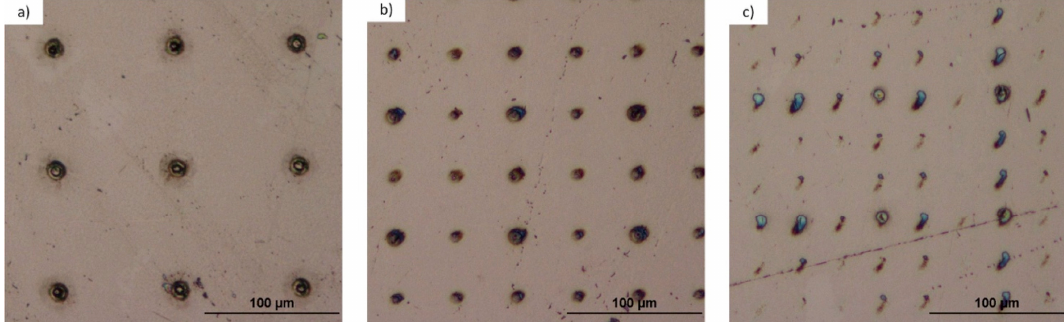
Figure 7. Optical microscope images obtained in reflected mode and bright field of the micropattern over a tantalum foil of 0.5 mm thickness obtained after the ablation using the foci of the microlenses when the surface is placed at the ( a ) first Talbot distance; ( b ) 3/2 Talbot distance; and ( c ) 5/3 Talbot distance.